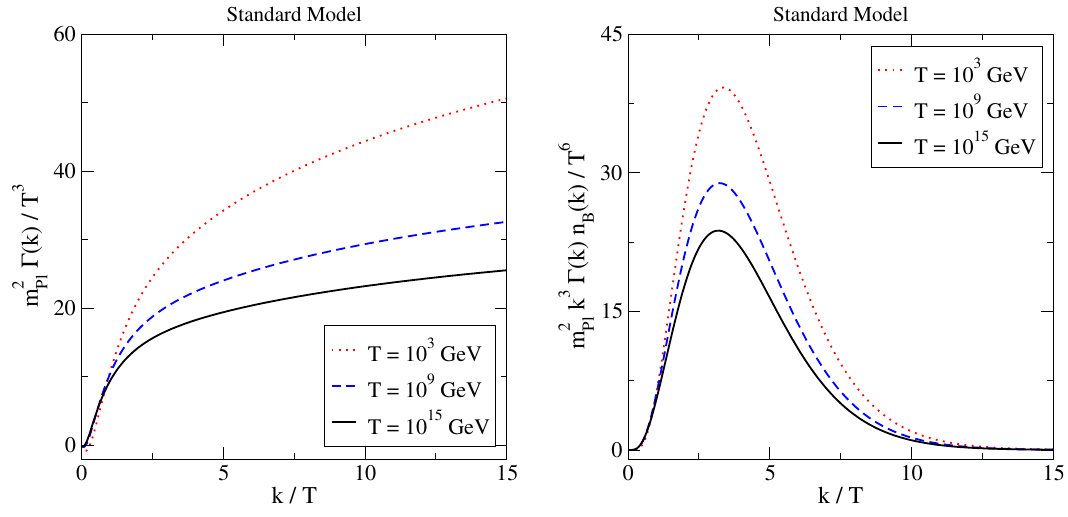
Figure 3 . Left: examples of the interaction rate (cid:0)( k ) from eq. (2.2) at a few representative temperatures, normalized to T 3 =m 2 . The interaction rate decreases in these units with temper- Pl ature, because the most important running couplings become smaller. Right: the combination m 2 k 3 (cid:0)( k ) n ( k ) =T 6 that plays a role for the production rate of the energy density carried by Pl B gravitational